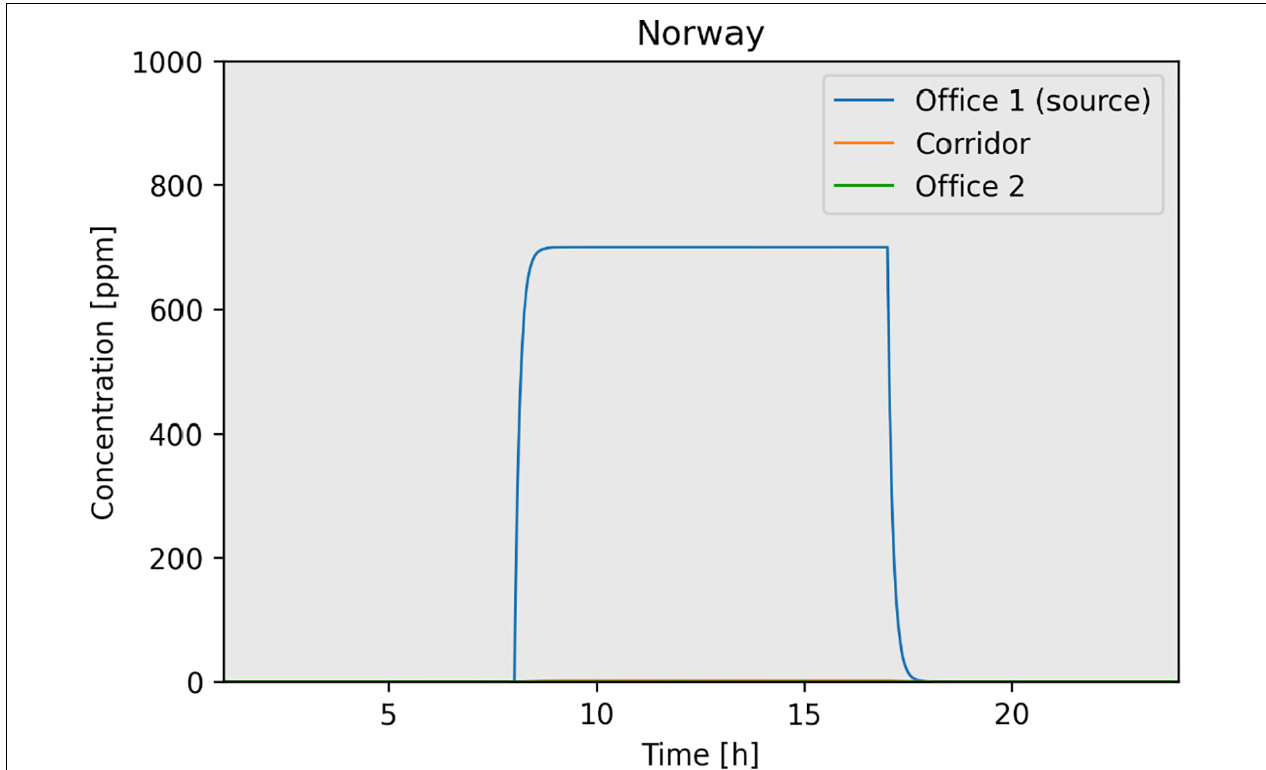
FIGURE 10 | Concentration of contaminants in typical Norwegian office buildings (background concentration excluded).